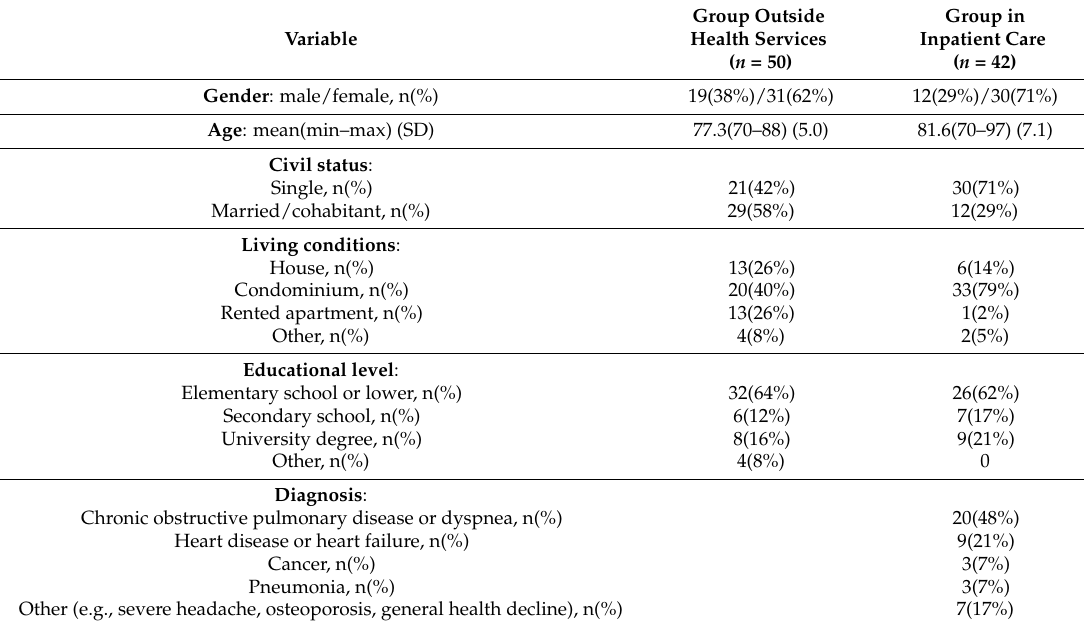
Table 3. Socio-demographics of the elderly